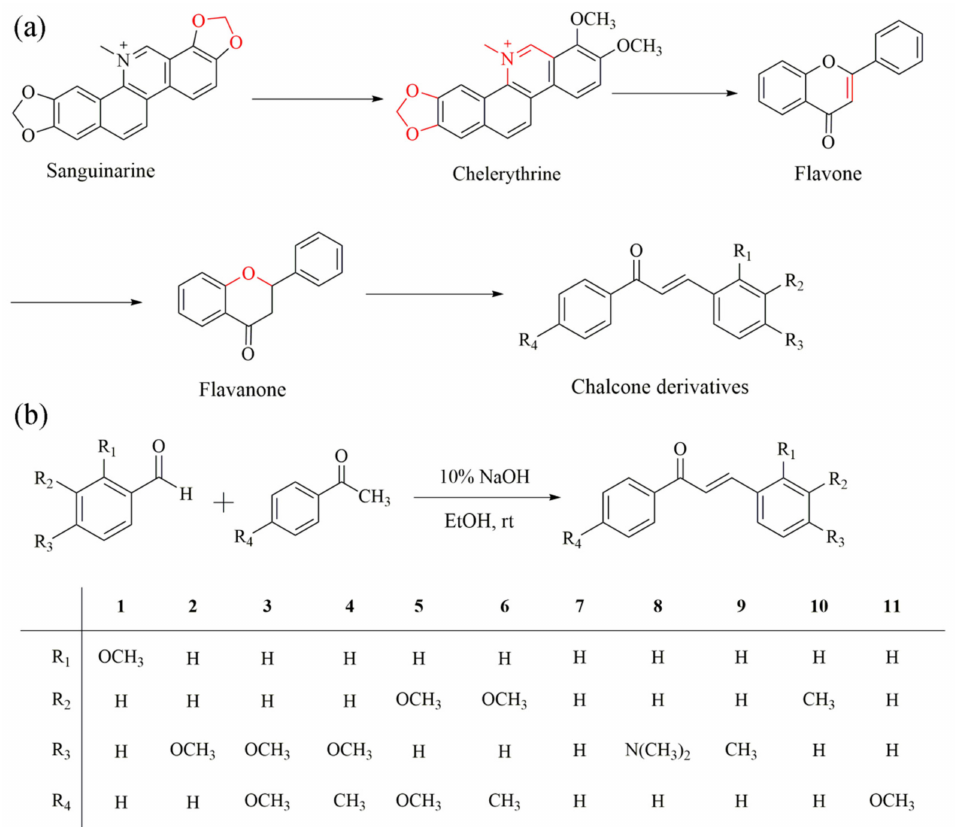
Figure 1. ( a ) Chemical structures of sanguinarine, chelerythrine, flavone, flavanone, and chalcone derivatives. ( b ) Synthesis route and chemical structure of chalcone derivatives 1 – 11